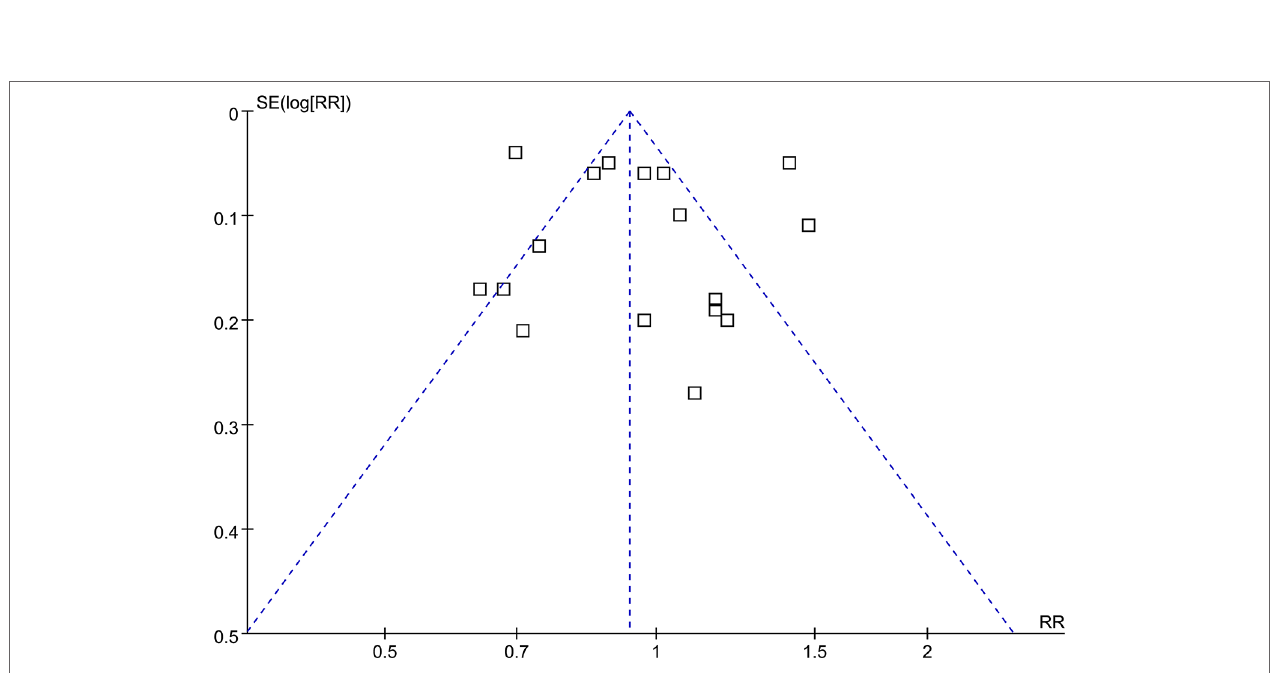
FIGURe 4 | Funnel plots for the meta-analysis of the association between the use of thiazide diuretics and the incidence of fracture.